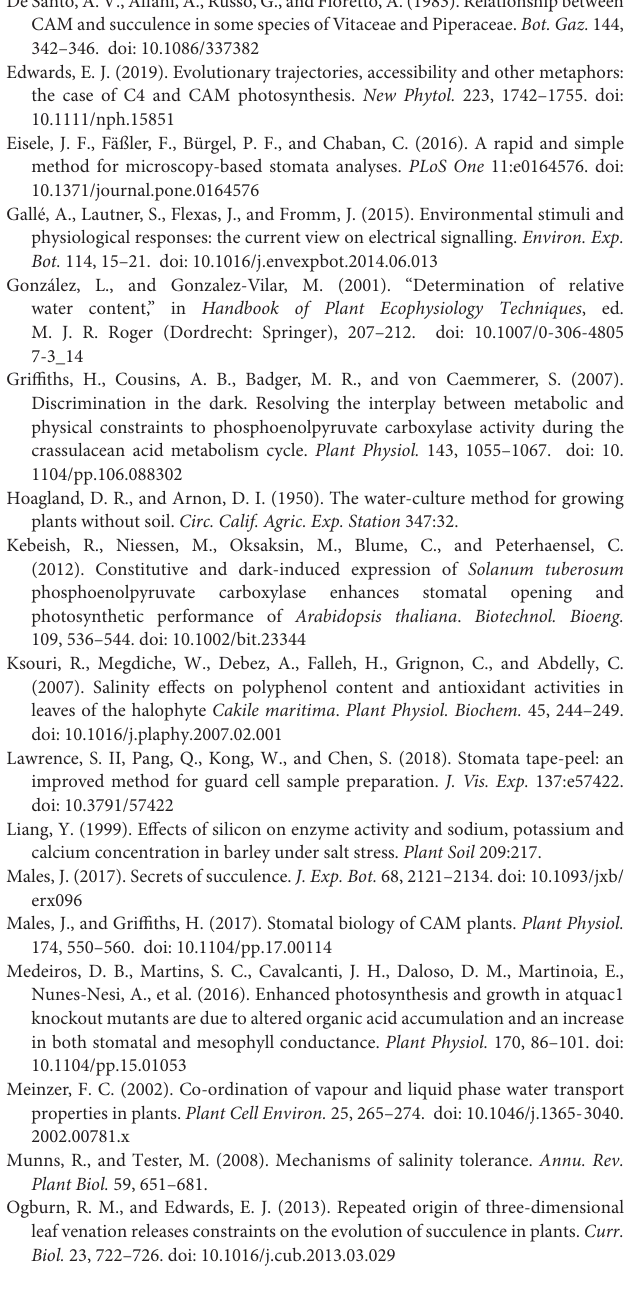
(D) Total reference pixels detected in the image, and white pixels represent the reference pixels. (E) Total leaf pixels detected in the plant image; light yellow pixels represent the pixels detected in green. FIGURE S2 | Stomatal aperture changes in day and night during the C 3 to CAM transition of M. crystallinum seedlings in the control and the salt groups. The data were collected at 4 am representing night and 4 pm representing day. FILE S1 | A python script for detecting green pixels as leaf pixels, with black pixels as reference pixels to calculate the leaf area by green pixels ∗ actual reference area divided by the reference